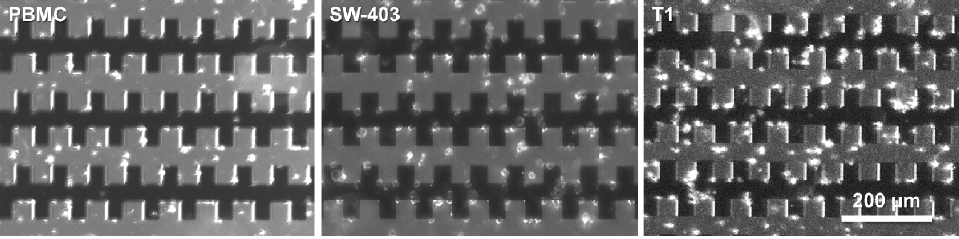
Figure 2. Microscopy images of a cell samples (PBMC, SW-403 and T1) distributions after DEP manipulation.